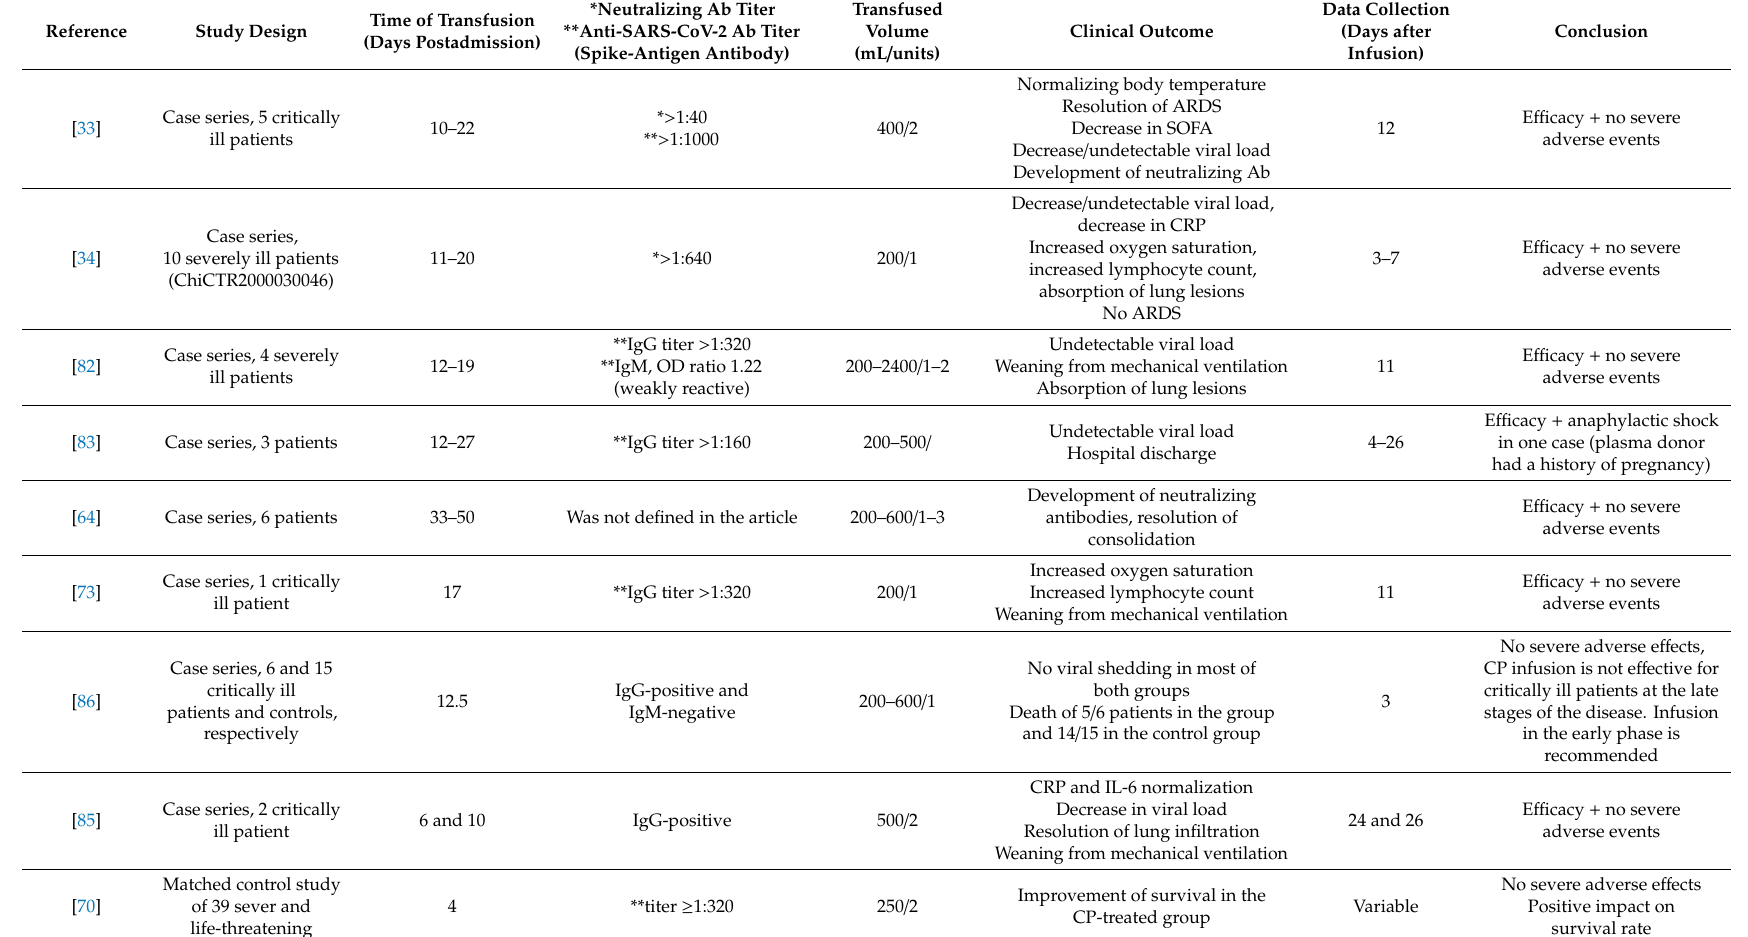
Table 1. Overview of clinical trial design and outcome for convalescent plasma (CP) therapy in COVID-19